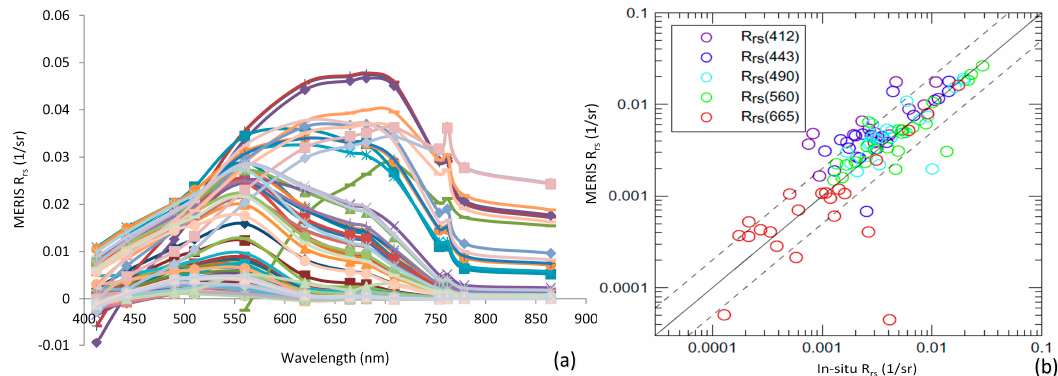
Figure 3. ( a ) Pixel reflectance spectra of one cloudless imagery MERIS 2P products (16 April 2003) corresponding to the station analyzed during the spring cruise in 2003. ( b ) Strictly match-up scatter plot of the MERIS R rs ( λ ) versus in-situ measurements during the spring and autumn cruises in 2003; the solid line is the 1:1 line, and dashed lines are the 1:2 and 2:1 lines.